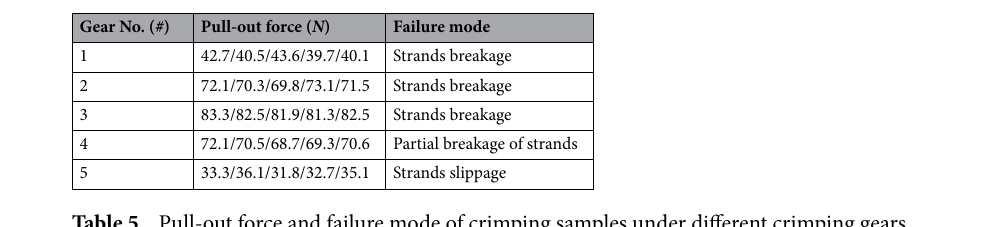
Table 5. Pull-out force and failure mode of crimping samples under different crimping gears.